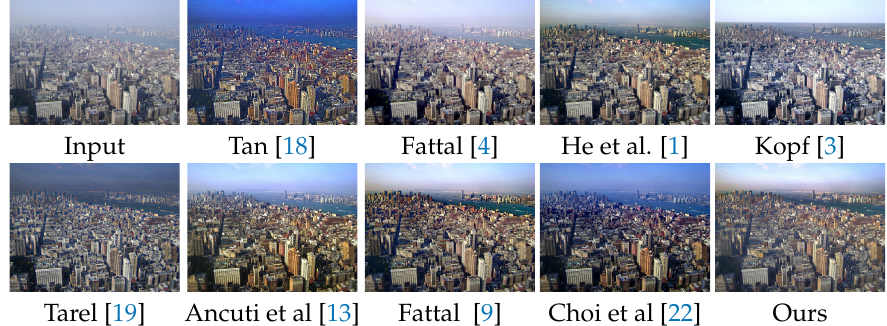
Figure 9. Visual comparisons on a real-world hazy image of